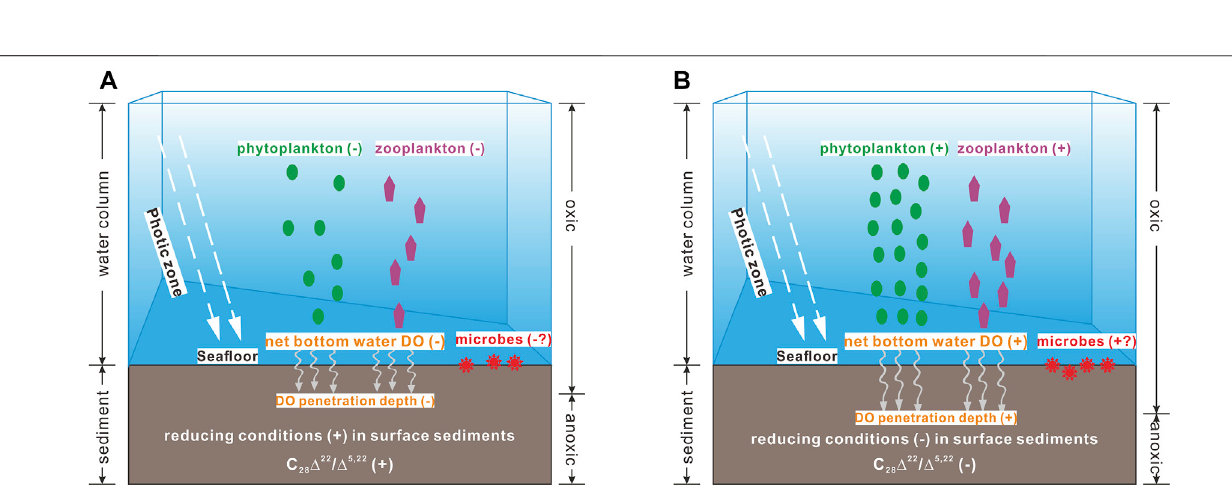
Frontiers in Earth Science |